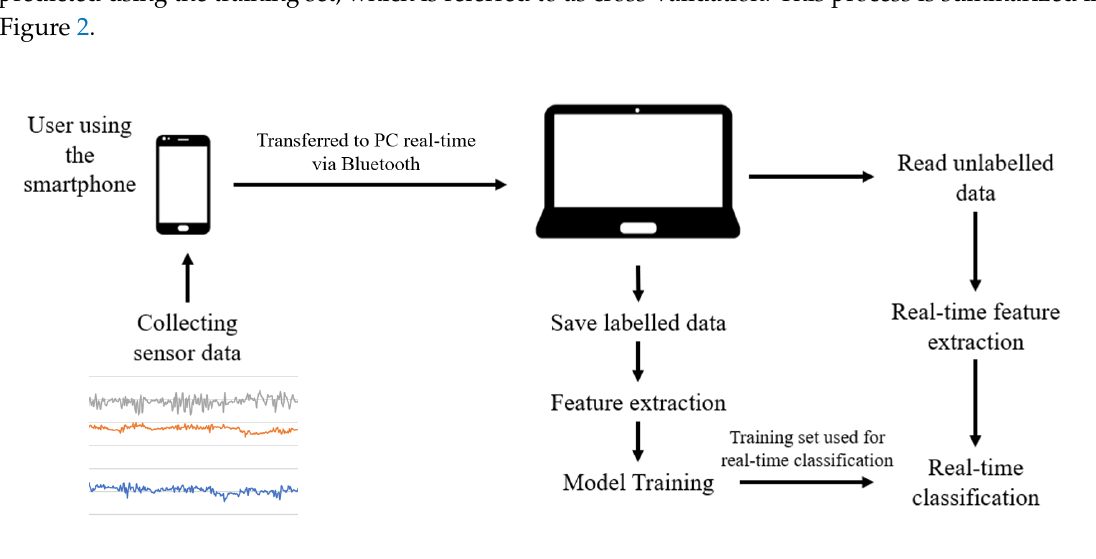
Figure 2. Study data collection and processing workflow: a user uses the smartphone for specified time periods and specified activities, while sensor data is recorded. In real time, data is transmitted and